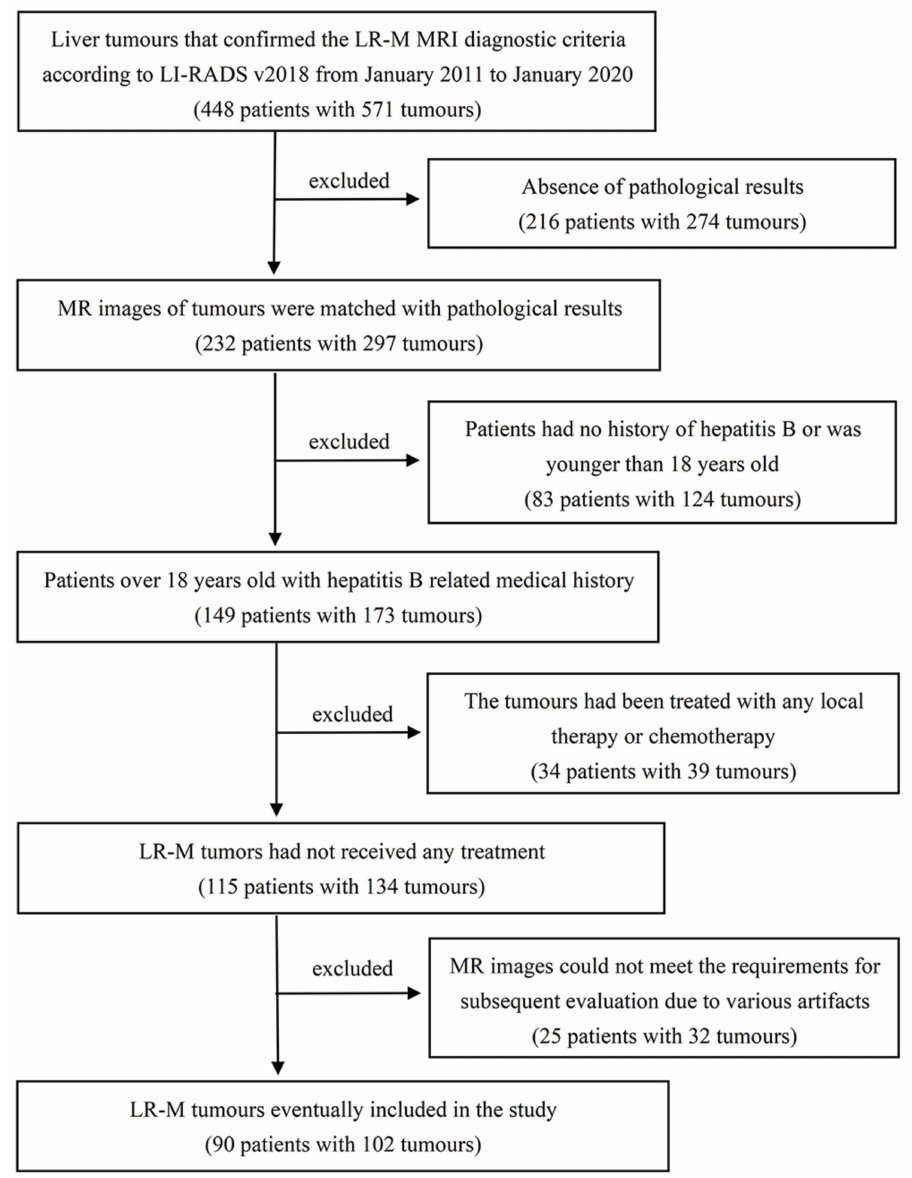
Figure 1. Flowchart showing the inclusion and exclusion of